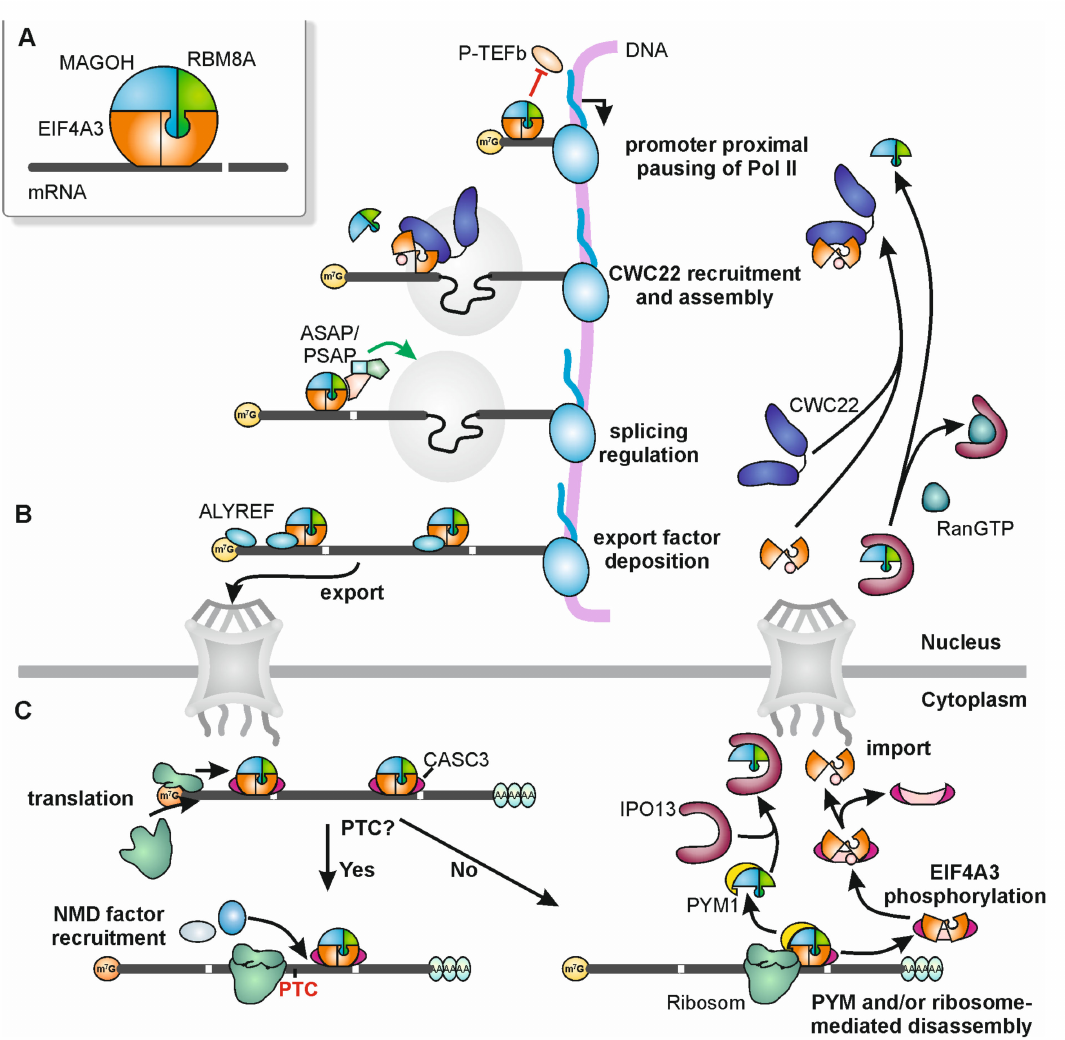
Figure 1. Exon junction complex (EJC) lifecycle. ( A ) Schematic representation of the trimeric EJC consisting of EIF4A3 and RBM8A–MAGOH. ( B ) Starting in the nucleus, the EJC escorts mRNAs and fulfills multiple functions regulating mRNA expression. Non-canonically deposited EJCs enhance promoter proximal pausing of RNA polymerase II (Pol II) by preventing Pol II association with P-TEFb. Canonical EJCs are recruited to the spliceosome via the interaction between CWC22 and EIF4A3 and are deposited 24 nucleotides (nts) upstream of an exon-exon junction. These EJCs can influence splicing via various mechanisms (see Figure 2 for details; ASAP: ACIN1-RNPS1-SAP18; PSAP: PNN-RNPS1-SAP18) and can stimulate the deposition of RNA export factors (e.g., ALYREF) onto the mRNA (see Figure 3 for details). ( C ) Before, during or after transport of the EJC-associated mRNAs to the cytoplasm, the EJCs undergo a compositional switch (see Figure 4 for details) and are removed from the mRNA during translation by ribosomes that can be equipped with PYM1 or by PYM1 alone. When a premature translation termination codon (PTC) is located su ffi ciently upstream of an EJC, this EJC is not removed during translation and therefore can induce nonsense-mediated mRNA decay (NMD) by recruiting NMD factors (see Figure 4 for details). EJCs that are removed by PYM1 are disassembled into the RBM8A–MAGOH heterodimer and the remaining EIF4A3 and CASC3. EIF4A3, which is in its open conformation, can be phosphorylated by CDK1 / 2 and re-imported to the nucleus by an unknown mechanism. The RBM8A–MAGOH heterodimer is imported to the nucleus by Importin 13